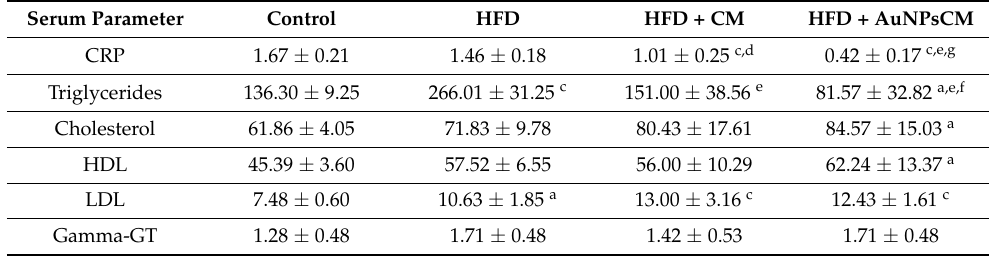
Table 1. Mean and standard deviations of investigated serum biochemical